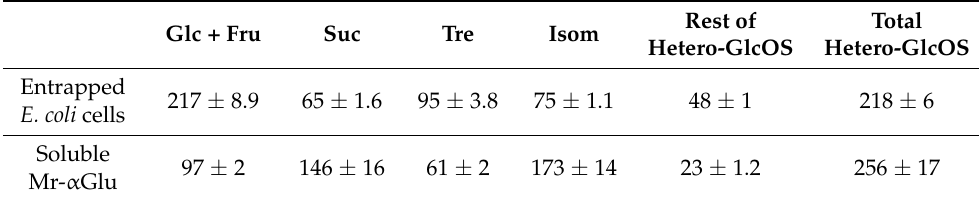
Rest of Total Hetero-GlcOS Hetero-GlcOS